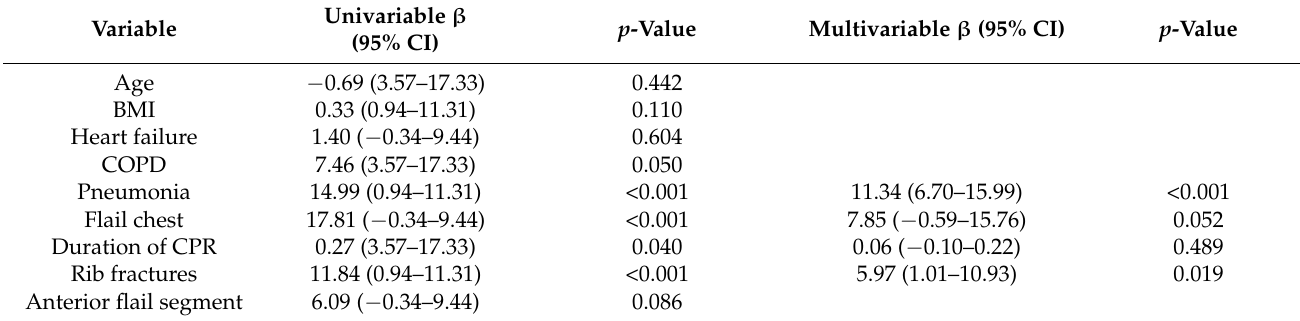
Table 5. Associations with the length of ICU stay in linear regression analysis.